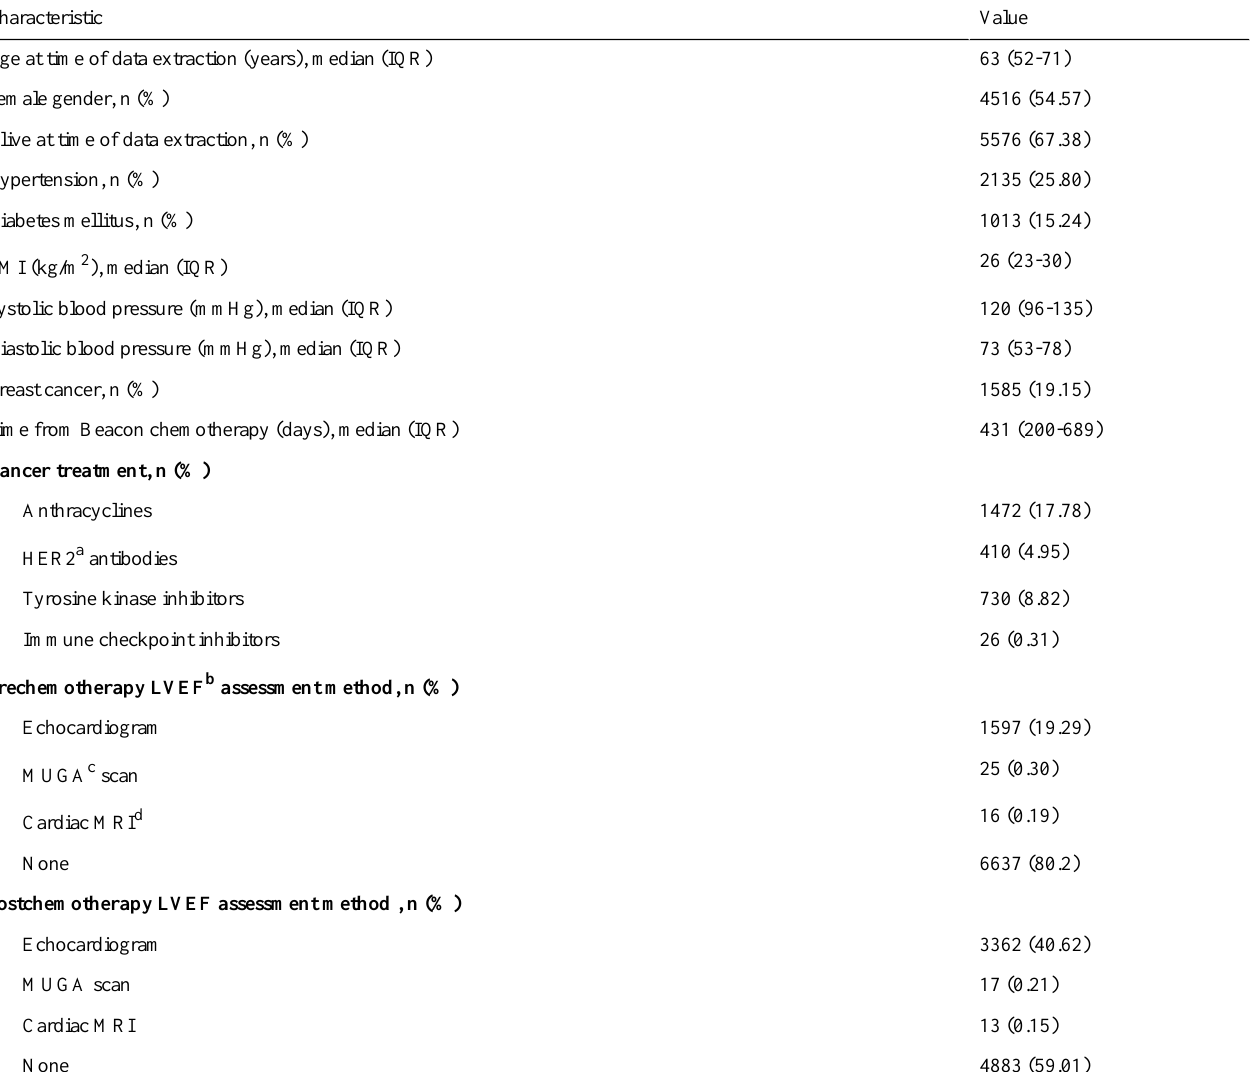
Table 1. Electronic health records–based cardio-oncology registry patient demographics and their clinical characteristics (N=8275).